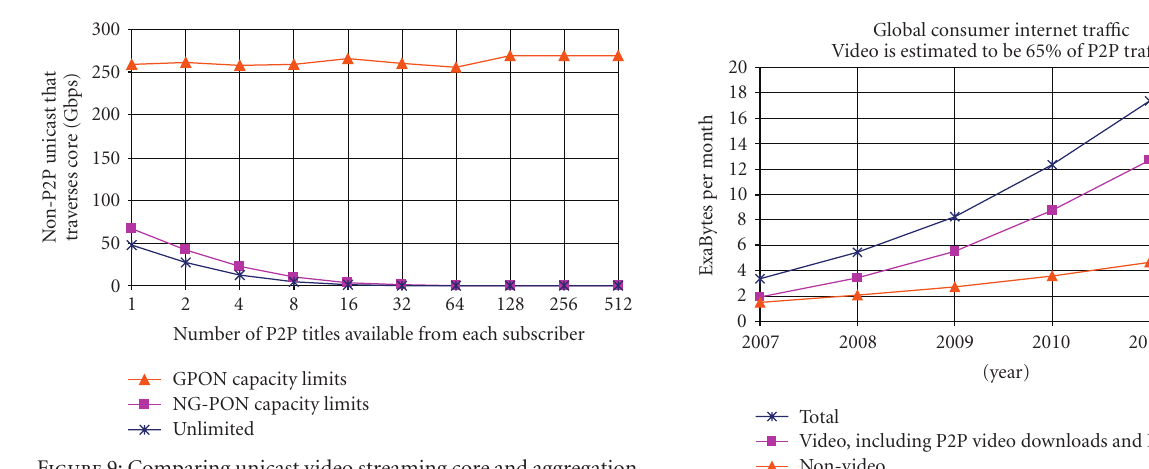
Figure 9: Comparing unicast video streaming core and aggregation bandwidth with GPON, NG-PON, and unlimited upstream capac- ity for P2P.